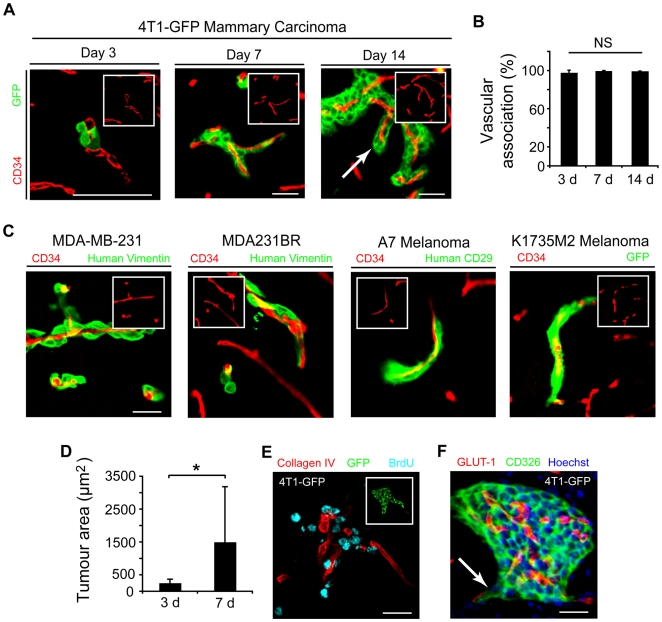
Vascular cooption of cancer cells in brain metastasis formation.(A) Histological analysis of 4T1-GFP microcolonies demonstrating intimate association with CD34+ capillaries (red) from 3 to 14 d after intracardiac injection of cells into syngeneic BALB/c mice. Insets are images of vessels in the absence of the tumor cells/green channel. Arrow shows angiocentric invasion. All scale bars, 30 µm. (B) Quantification of tumor-vascular association of 4T1-GFP at 3, 7, and 14 d (n = 3–4 per timepoint). (C) Early brain microcolonies from human cell lines MDA-MB-231, MDA-MB-231BR, and A7 and the murine melanoma K1735M2-GFP demonstrated similar vascular cooption (as indicated). Insets as in (A). Scale bar, 30 µm. (D) Cross sectional tumor area measured at 3 and 7 d demonstrates rapid growth over this time (*P<0.05, t-test; n = 256 colonies analyzed, 3–4 mice per timepoint). (E) Immunofluorescence for BrdU (cyan) in a tumor colony at 7 d demonstrates a high proportion of proliferative perivascular cells within the colony shown in the inset in green. Scale bar, 30 µm. (F) Projection image of a spontaneous 4T1-GFP brain micrometastasis demonstrates similar features to colonies from the intracardiac model such as Glut-1 positive vessels (red) and angiocentric invasion (arrow). CD326 is an epithelial tumor marker that only stains the tumor cells. Scale bar, 30 µm. Error bars represent s.d.